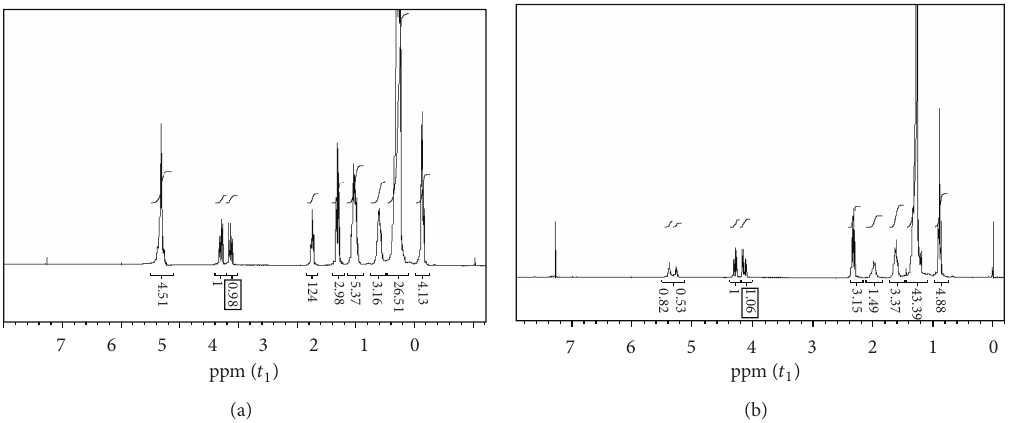
F 1: Comparison of the 300MHz